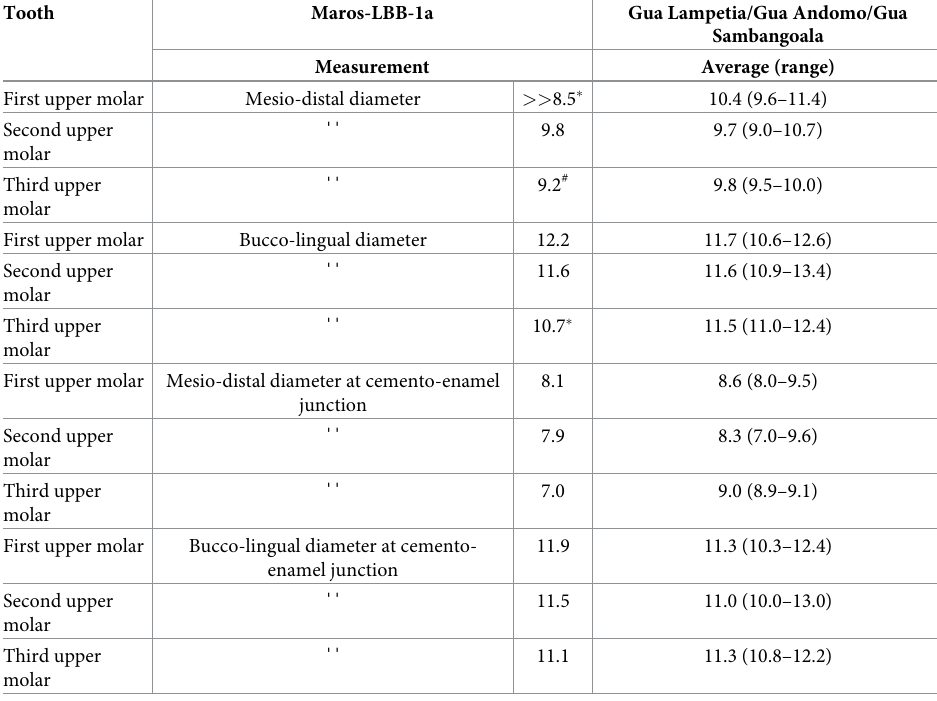
Table 4. Diameters (mm) of the Maros-LBB-1a molars, with Southeast Sulawesi comparisons (from [54]; Bulbeck laboratory